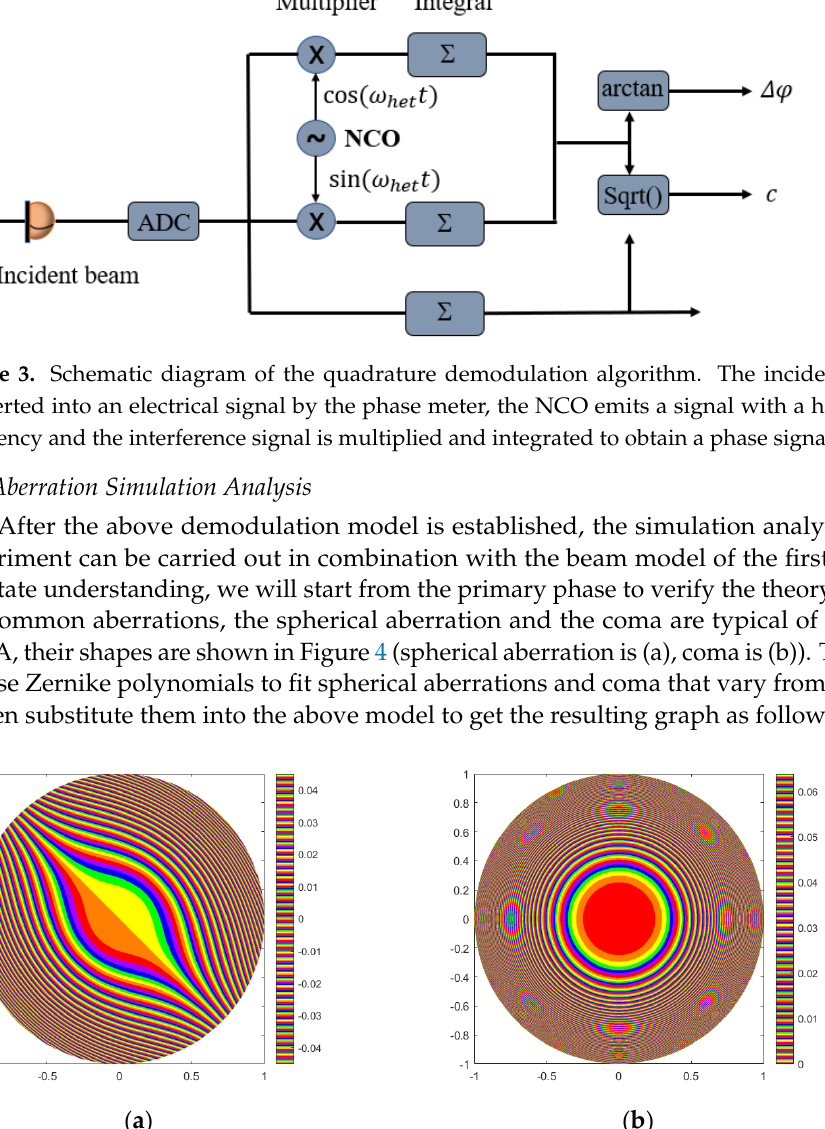
Figure 5. The abscissa refers to the magnitude of the aberration from λ/100 to λ . The ordinate rep- resents the final demodulated phase size. Red represents the phase that changes with the magnitude of the spherical aberration. Blue represents the phase that changes with the magnitude of the coma. In actual telescope systems, aberrations are extremely complex, including not only primary aberrations but also advanced aberrations. Therefore, we simulated a more gen- eral aberration composition, and to see the effect more clearly, we used the Monte Carlo algorithm to randomly assign the first 15 terms of the Zernike polynomial and fix its total aberration size at λ/60. Then , we obtained a comparison chart (Figure 6) of removing the non-rotationally symmetrical aberrations and not removing them.